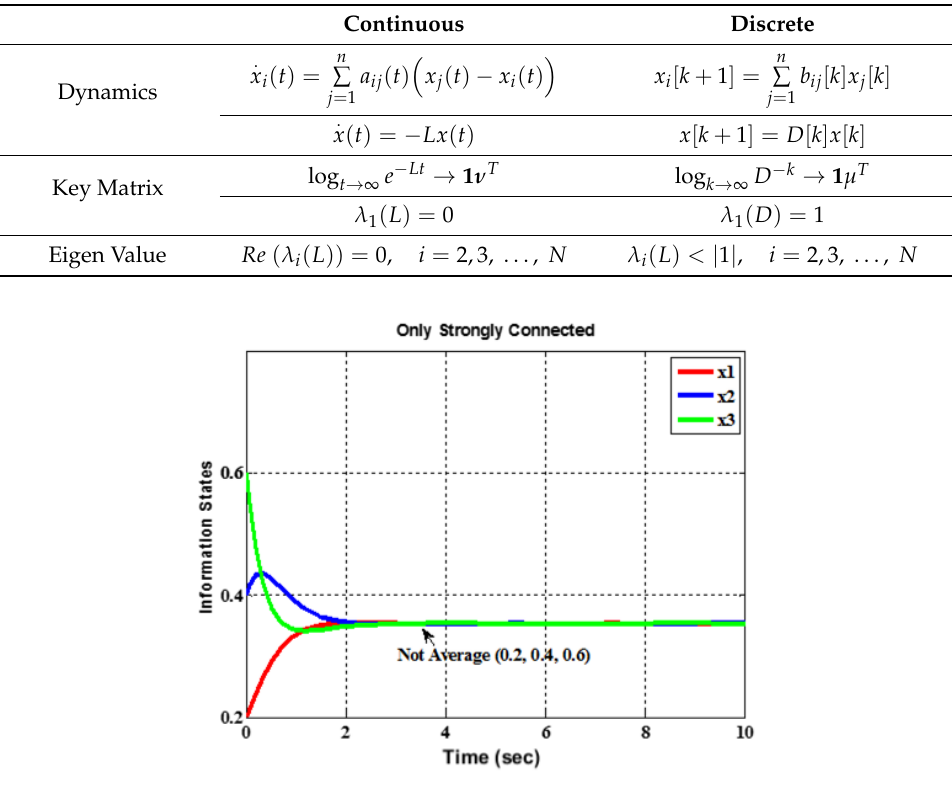
Table 1. Continuous vs. Discrete: Consensus Comparison.